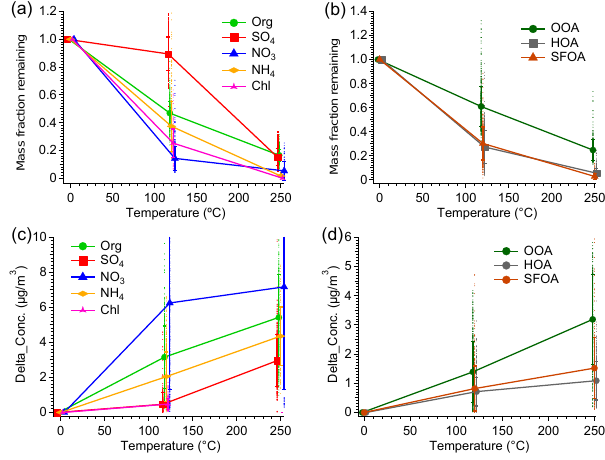
Figure 9. Thermogram of (a) non-refractory species and (b) OA factors. The change in mass concentration after heating in the TD (i.e., (cid:49)C ) of (c) non-refractory species and (d) OA factors. Error bars indicate 1 standard deviation. The average values are connected by lines to guide the